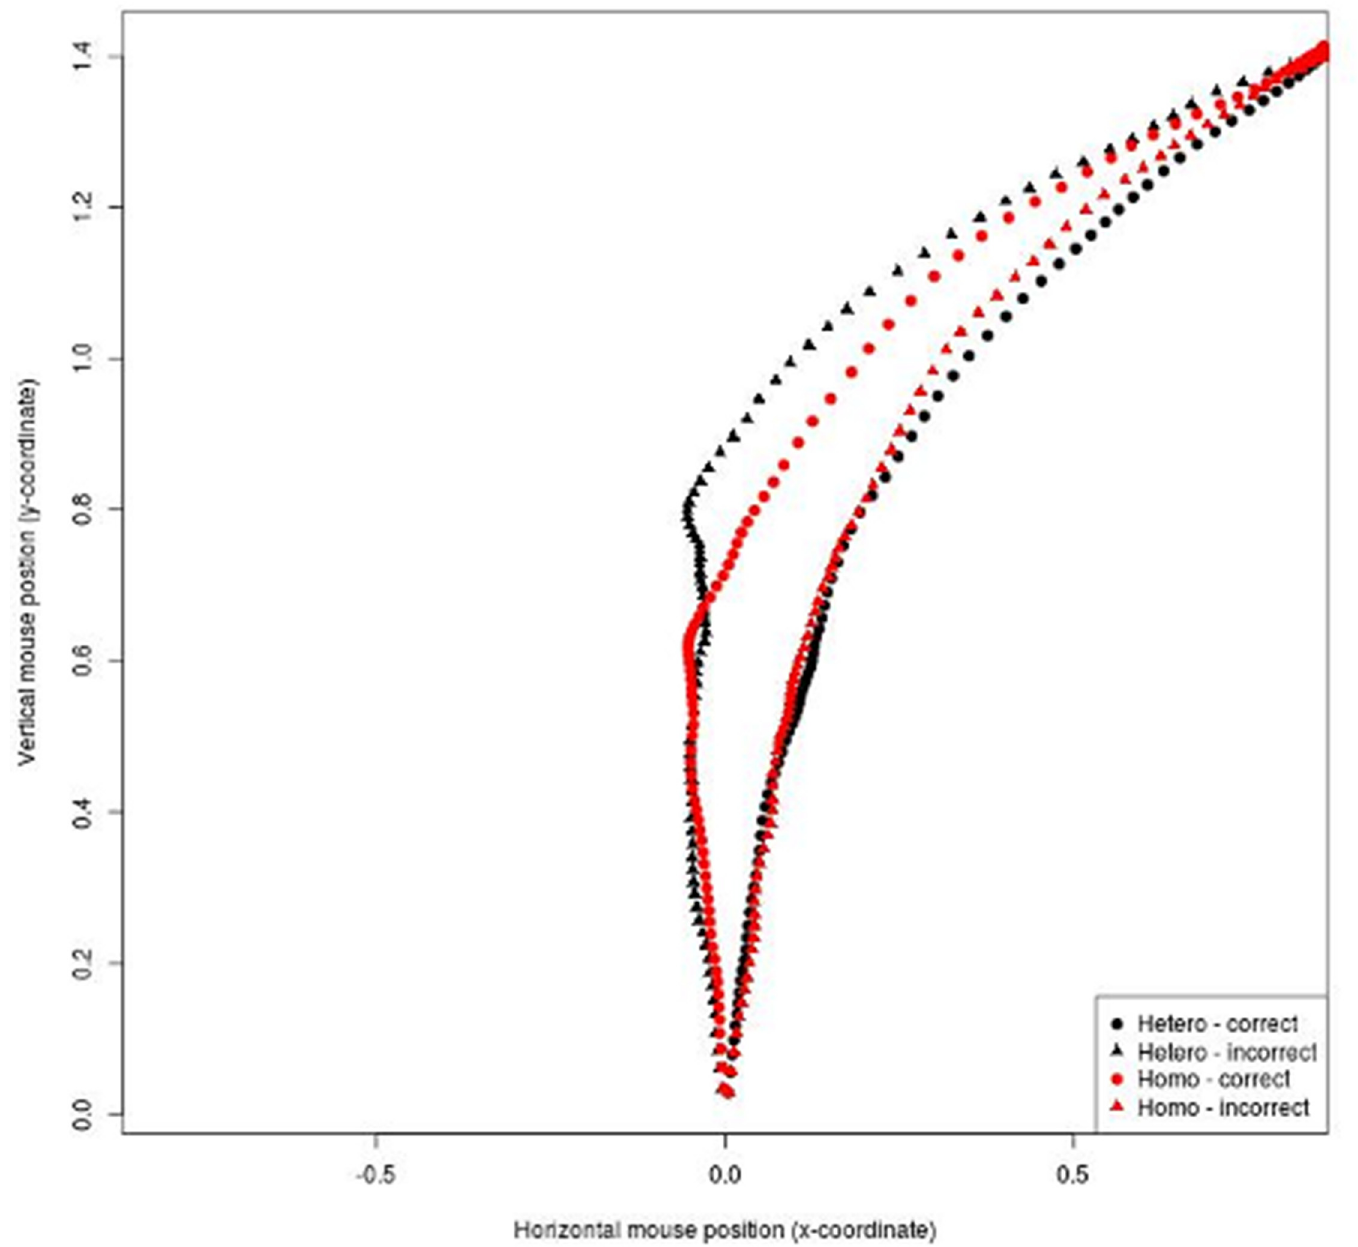
Fig 3. Experiment 1B (Germans): Mean mouse trajectories for correct and incorrect responses for heterosexual and gay speakers.